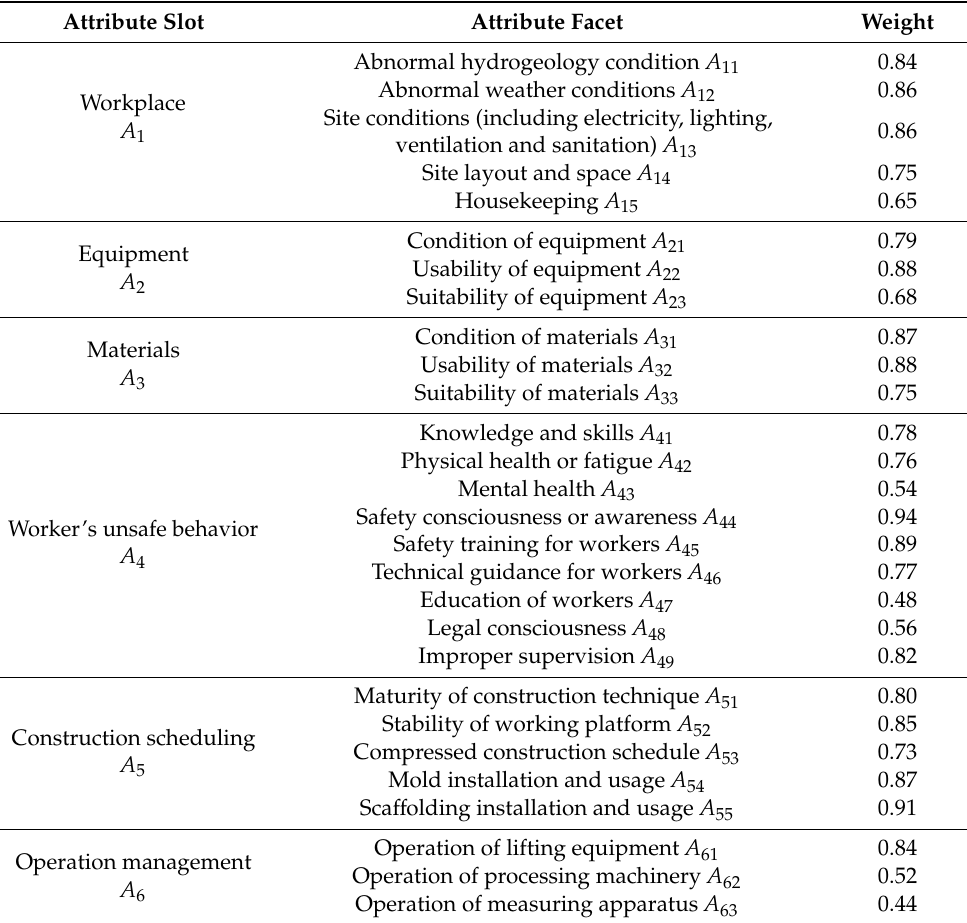
Table 4. Weight of attribute facets.